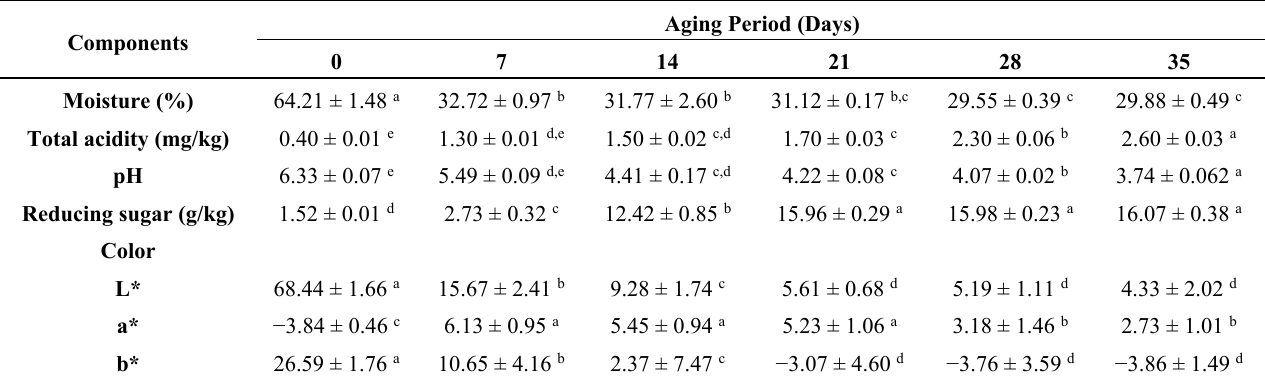
Table 1. Physicochemical characteristics of black garlic during aging period.